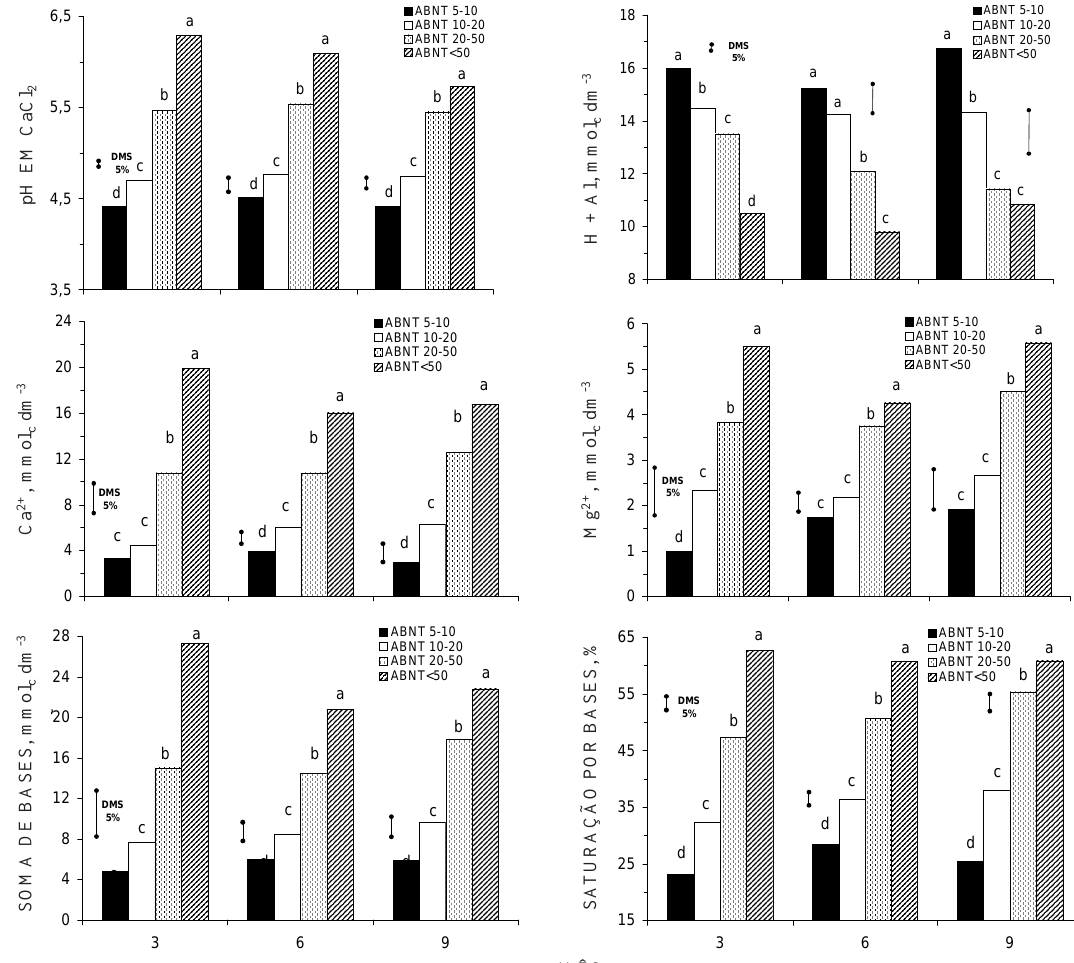
Figura 1. Frações granulométricas da escória de siderurgia de aciaria no valor pH, concentrações de H + Al, Ca 2+ , Mg 2+ , soma de bases e na saturação por bases de um Latossolo Vermelho distrófico, após três, seis e nove meses de incubação (média de três doses e quatro